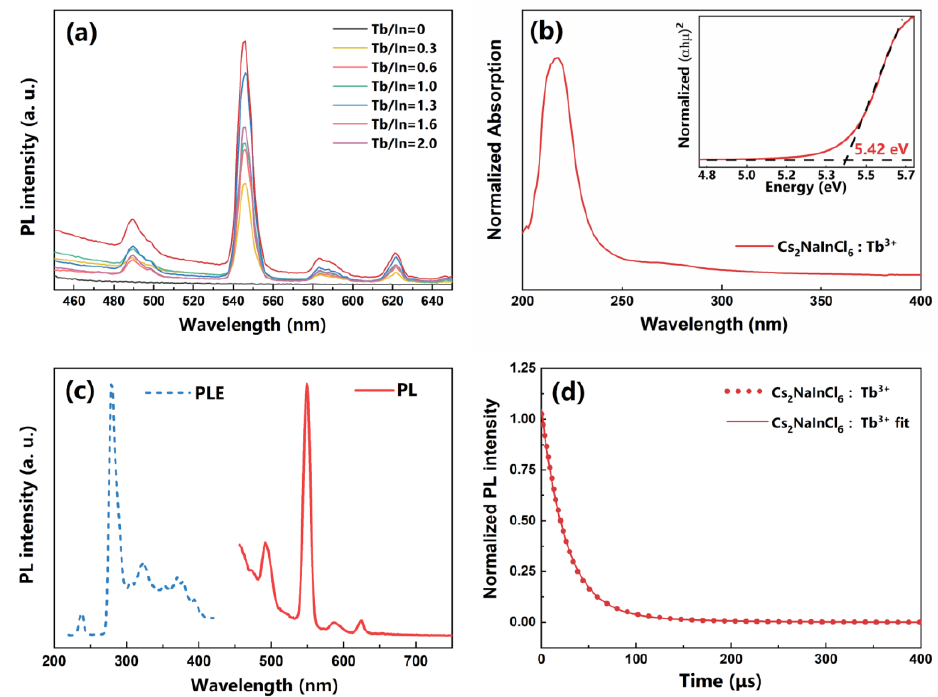
Figure 2. ( a ) PL spectra under 280 nm excitation for Cs 2 NaInCl 6 NCs with different Tb 3+ doping ratios. ( b ) Diffuse reflection absorption spectrum; insert shows the corresponding Tauc plots of Tb 3+ - doped Cs 2 NaInCl 6 NCs. ( c ) PLE and PL, ( d ) time-resolved PL spectra of the Tb 3+ -doped Cs 2 NaInCl 6 NCs with fitting curves.